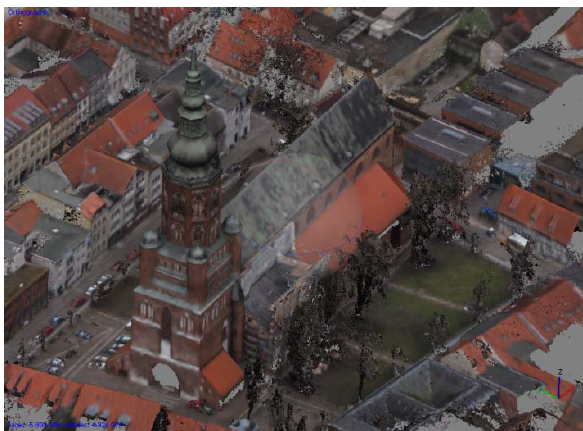
Figure 1. Cathedral St. Nikolai in Greifswald, Germany Figure 2. Photorealistic textured DSM of the cathedral and the